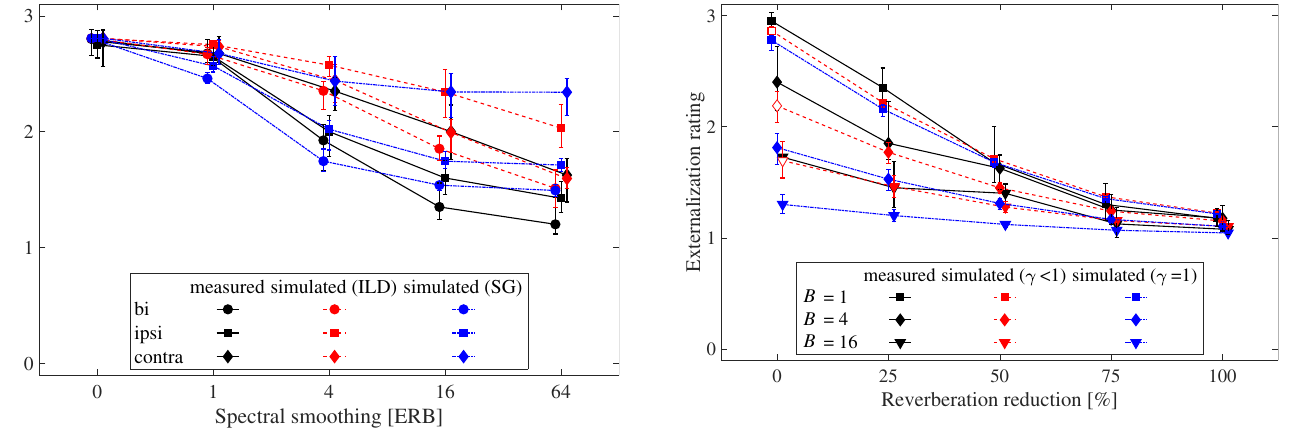
Figure 8. Median values of predicted externalization ratings using a single acoustic cue (ILD or SG deviations) by reducing the spectral details in HRTFs of both ears (condition “ bi ” ), the ipsilateral ear (condition “ ipsi ” ) and the contralateral ear (condition “ contra ” ) across subjects. ILD- and SG-based predic- tion results are plotted with dashed and dash-dotted lines, respectively. All other conventions are as in Figure